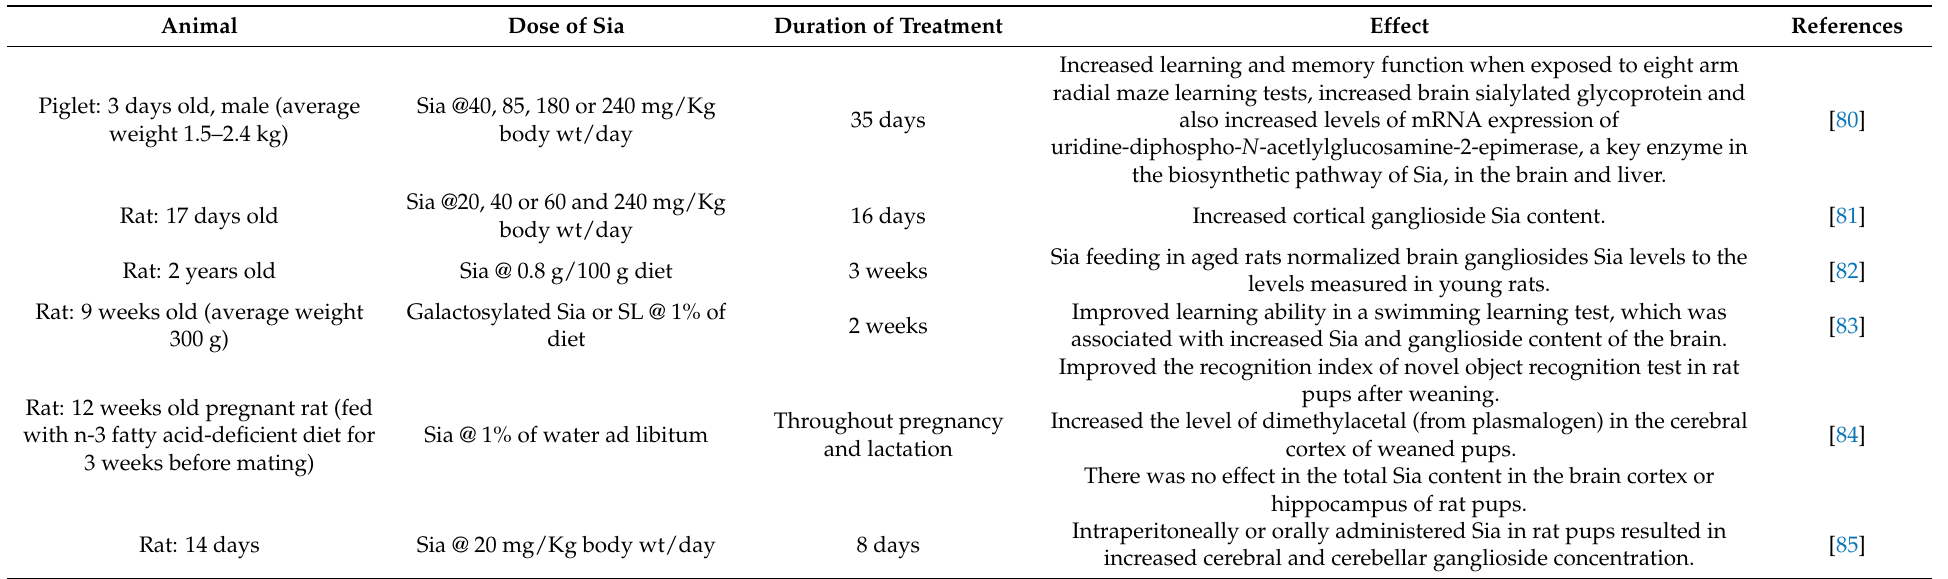
Table 2. A summary of studies exploring the in vivo effect of oral Sia supplementation in brain development and cognition in rodents and